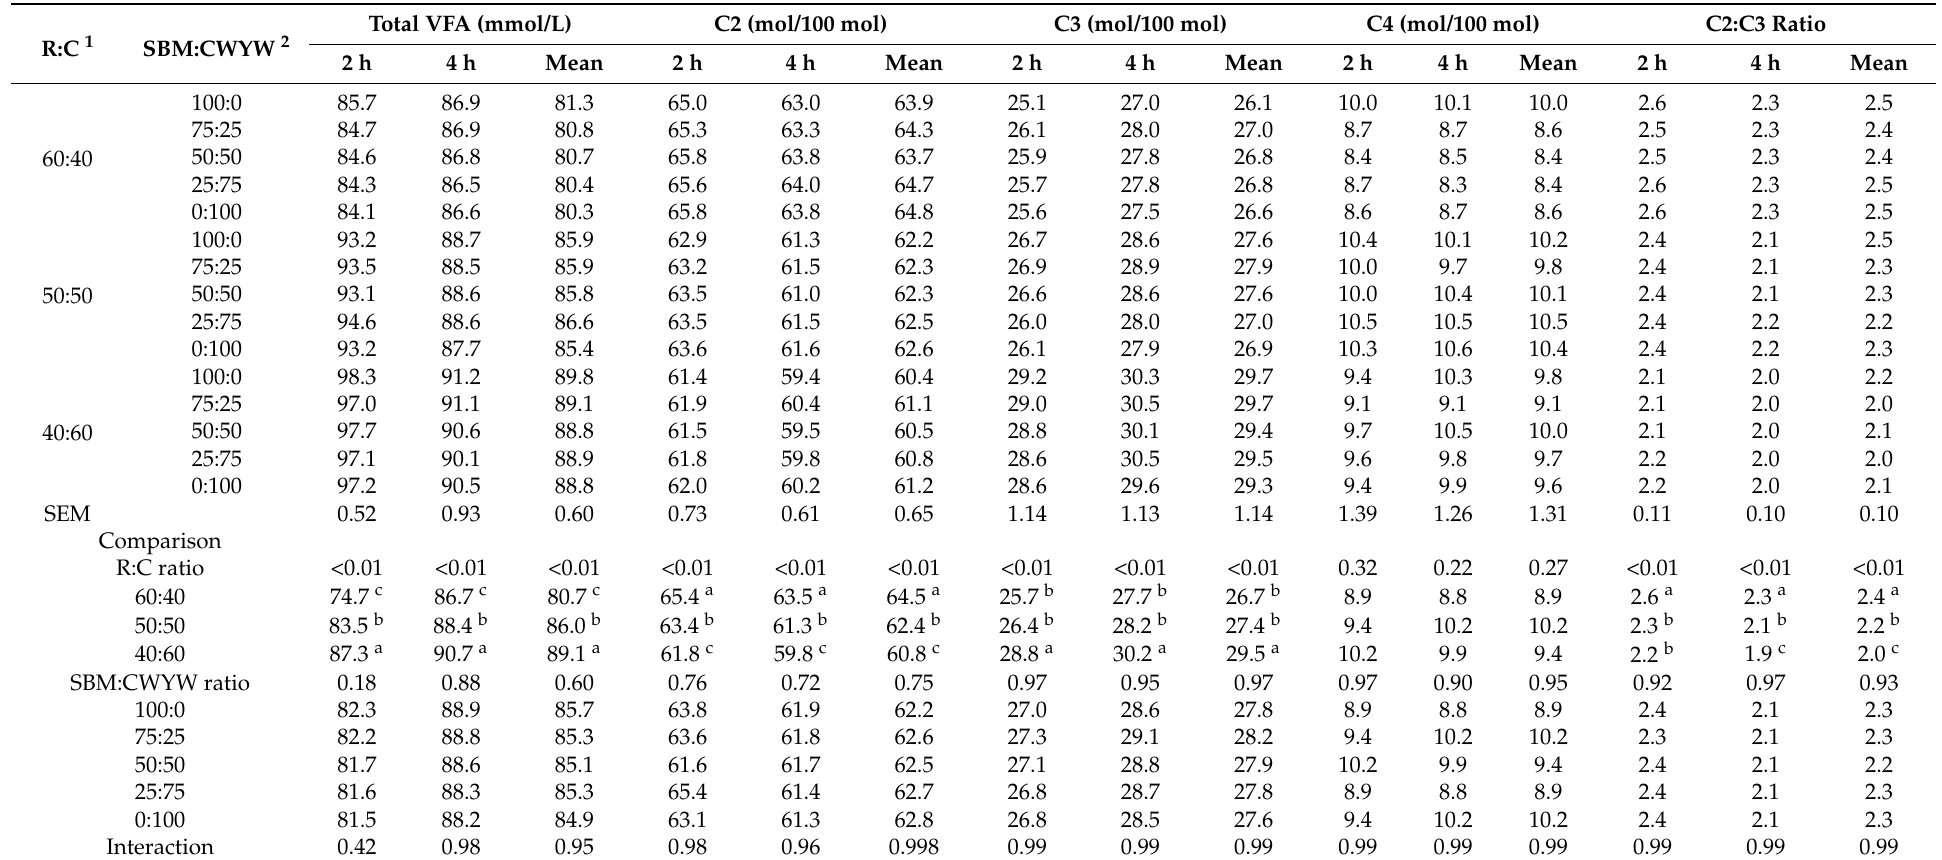
Table 5. Effect of R:C ratio level combined with SBM:CWYW ratio level on in vitro volatile fatty acids